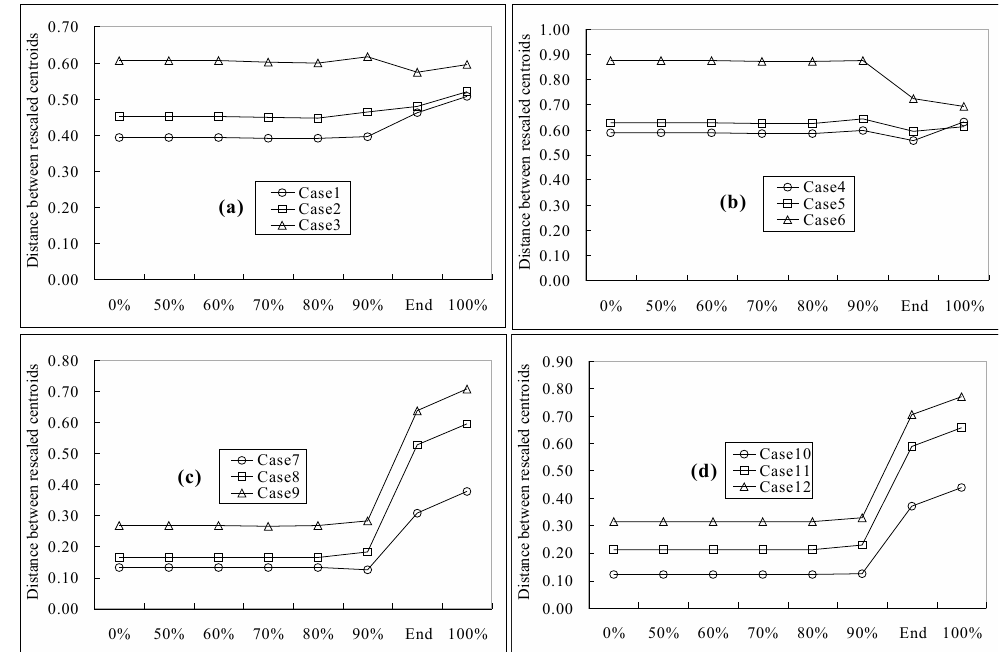
Figure 9. Distances of the centroids between the new base case and other cases at different stages of head recovery in the heterogeneous cases.